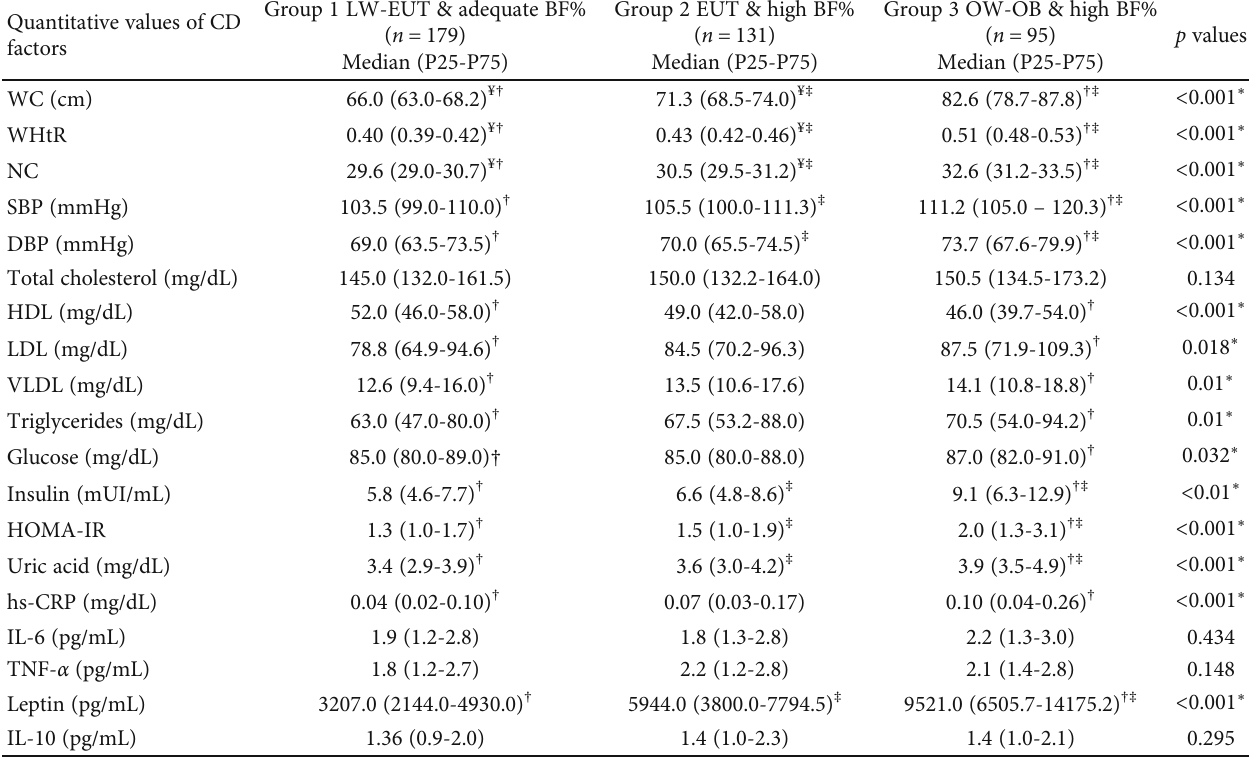
Table 2: Quantitative values of the cardiometabolic disease risk factors among the groups of body composition. Quantitative values of CD